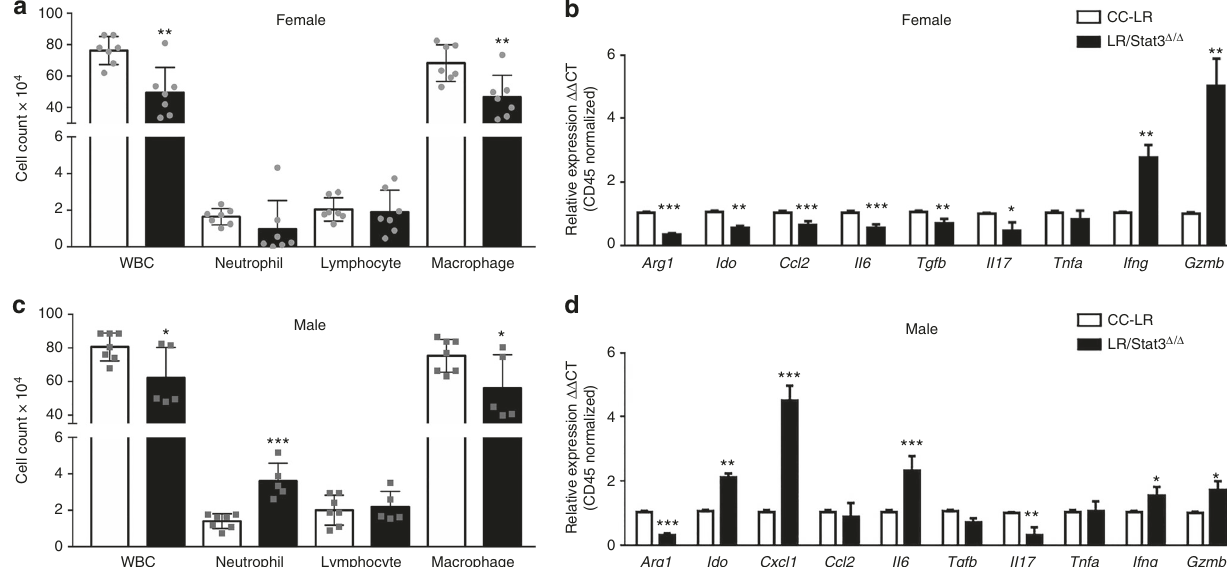
Fig. 3 Epithelial Stat3 deletion changes the lung tumor microenvironment in a sex-dependent manner. Total in fl ammatory cell and lineage-speci fi c leukocyte numbers from bronchoalveolar lavage fl uid (BALF) of female ( n = 7) ( a ) and male ( n = 5 – 7) ( c ) CC-LR and LR/ Stat3 Δ / Δ mice at the age of 14 weeks. Relative expression of Arg1 , Ido , Cxcl1 , Ccl2 , Il6 , Tgfb , Il17 , Tnfa , Ifng and Gzmb mRNA in whole lungs of female ( b ) and male ( d ) CC-LR and LR/ Stat3 Δ / Δ mice at the age of 14 weeks, normalized by CD45 expression (data represent means± SEM; *** P < 0.001; ** P < 0.005; * P < 0.05 using two-tailed t - test, experimental replicate # 2-3). WBC, white blood cell